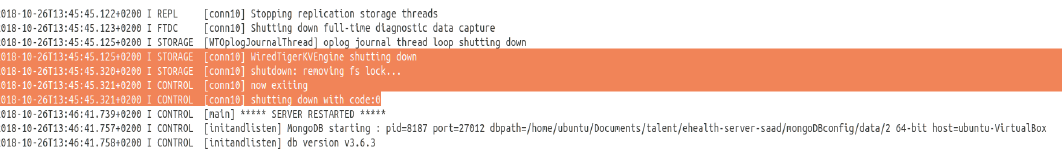
Figure 7. Primary database